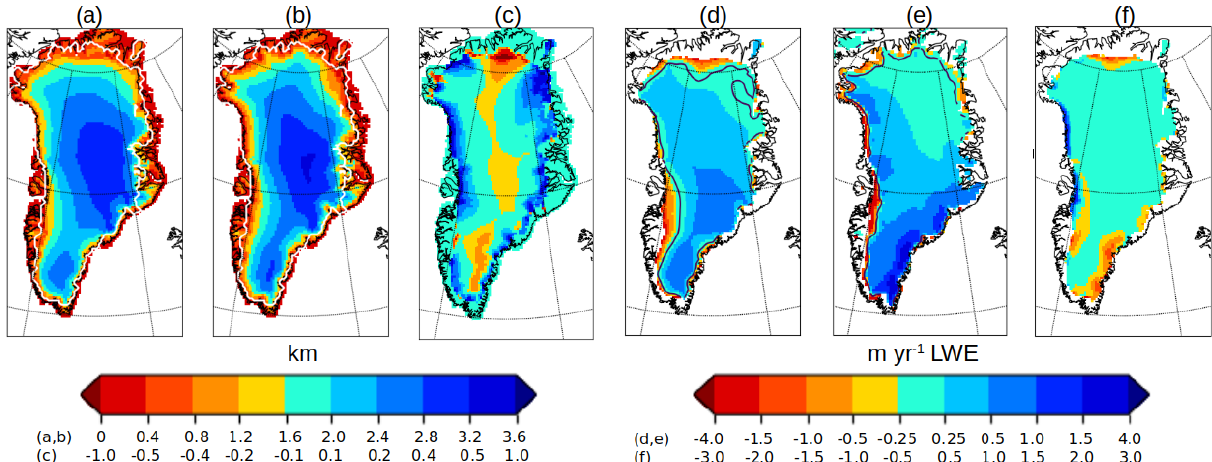
Figure 1. (a, b) Greenland surface elevation above sea level in (a) FAMOUS–ice (medium albedo) and (b) observations (Bamber et al., 2001a, b). The white contour is the observed ice margin and is the same in both maps. (c) Difference between (a) and (b) ; positive means FAMOUS–ice surface is higher. (d, e) Specific surface mass balance (expressed as liquid water equivalent) for the climate of MIROC5 1980–1999 in (d) FAMOUS–ice (medium albedo) and (e) MAR. The black contour is the equilibrium line (where specific SMB is zero). (f) Difference between (d) and (e) ; positive means FAMOUS–ice SMB is more